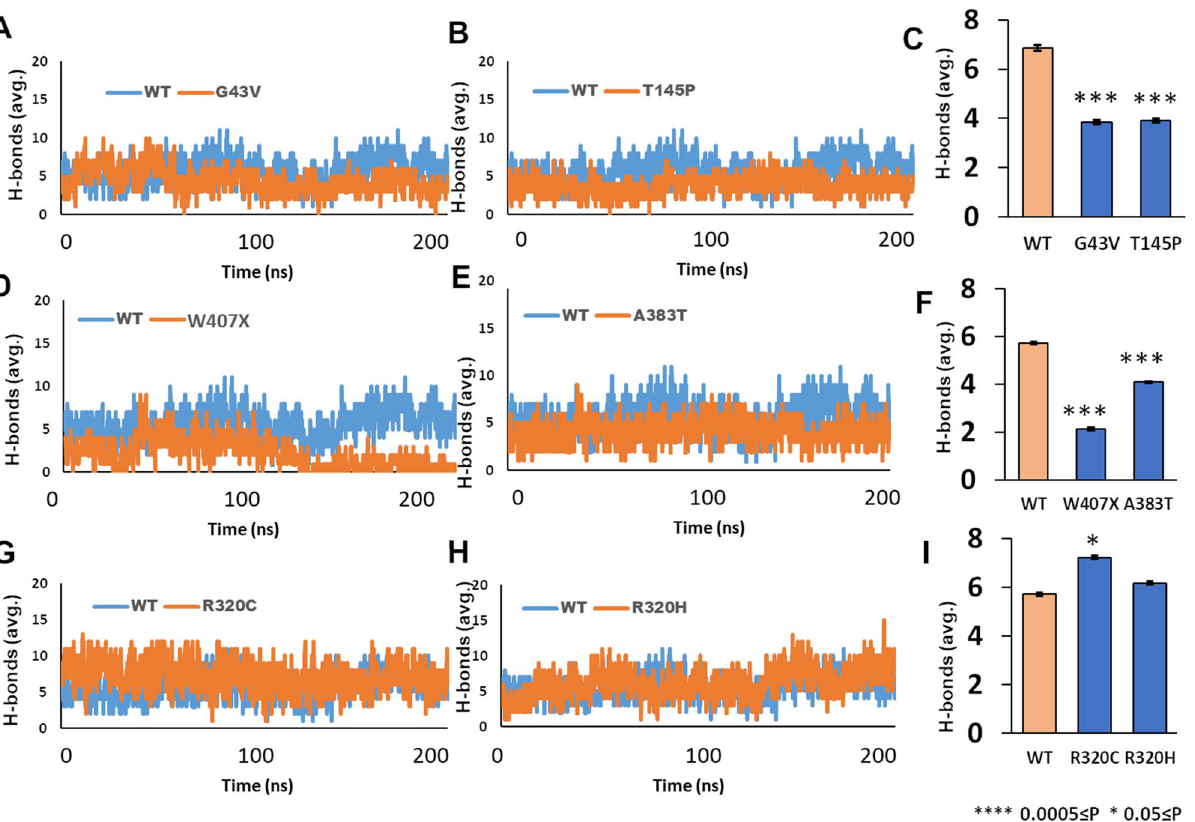
Figure 4. MD simulations predict destabilization of mutated tubulin α:β heterodimers with bound GTP. ( A , B , D , E , G , H ) Calculated intermolecular hydrogen bonds linking wild-type tubulin β chain to wild-type (blue) or mutant (orange) tubulin α chain, over 200-ns molecular-dynamic simulations of α:β heterodimers. ( C , F , I ) Histograms summarize average hydrogen-bond totals connecting WT or mutant α chains to wild-type β chain during the last 50 ns of each